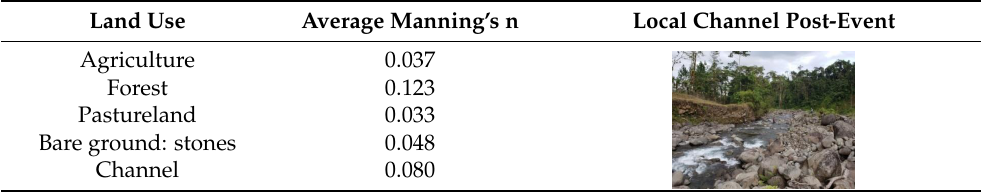
Table 2. Manning’s n values for different land use in the sub-basin study area. Land Use Table 2. Manning ’ s n values for different land use in the sub-basin study